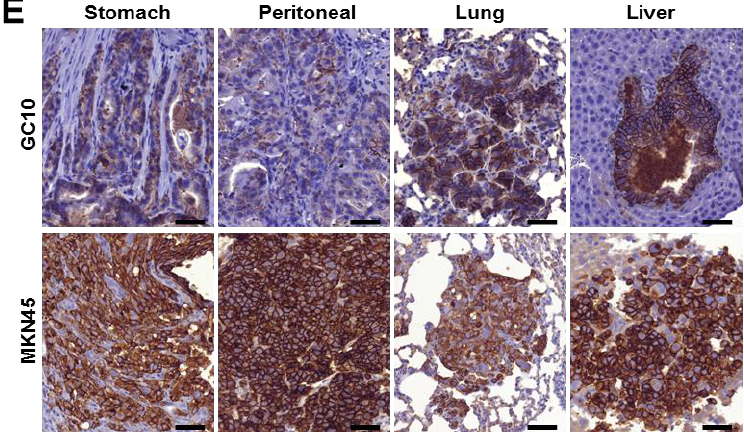
Figure 3. Metastases are enriched in cancer stem cells (CSC). ( A , B ) Quantification (left panel) and representative images (right panel) of the tumorspheres formed in vitro by GC10 CSC ( A ) and MKN45 CSC ( B ) derived from primary tumors of the stomach and distant metastases (peritoneal, lung, and liver). The arrows indicate tumorspheres. Data represent the min to max; n ≥ 3 mice with nine replicates per experiment and per mice. * p < 0.05 in one-way ANOVA and Student’s t -test. Scale bars, 50 µm. ( C , D ) Flow cytometry dot plots ( C ) and quantification ( D ) of the percentage of CD44-positive cells in primary stomach tumors and metastases derived from GC10 and GC07 cases. Data represent mean ± SEM. of n ≥ 3 mice in Kruskal–Wallis and Student’s t -test. ( E ) Representative images of CD44 expression detected by immunohistochemistry on tissue sections of stomach tumors and peritoneal, lung, and liver metastases obtained in GC10 and MKN45 orthotopically xenografted mice. Scale bars: 50 µm.